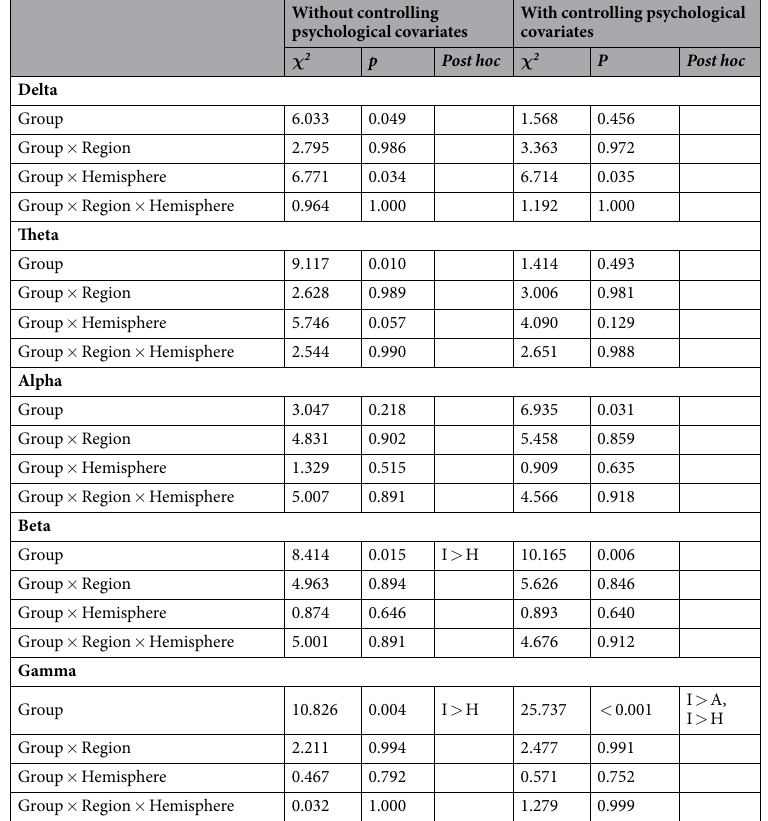
Table 2. Factor effects on EEG intrahemispheric coherence. Effects on EEG intrahemispheric coherence with or without controlling effects of psychological variables (scores on the BDI-II, BAI, and BIS-11) were analyzed separately for each frequency band. Effects of demographic data (age, education, and IQ) variables were controlled in all conditions. Bonferroni correction was applied to the post hoc analysis, and the significance level was set at 0.0167. Fisher’s Z-transformed scores were used for the EEG data. The group factor consists of IGD (n = 30), AUD (n = 30), and HC (n = 32). The region factor consists of following pairs: fronto-central, fronto-temporal, fronto-parietal, centro-temporal, centro-parietal, temporoparietal. The hemisphere factor consists of left and right side. EEG = electroencephalography; IGD (I) = Internet gaming disorder;